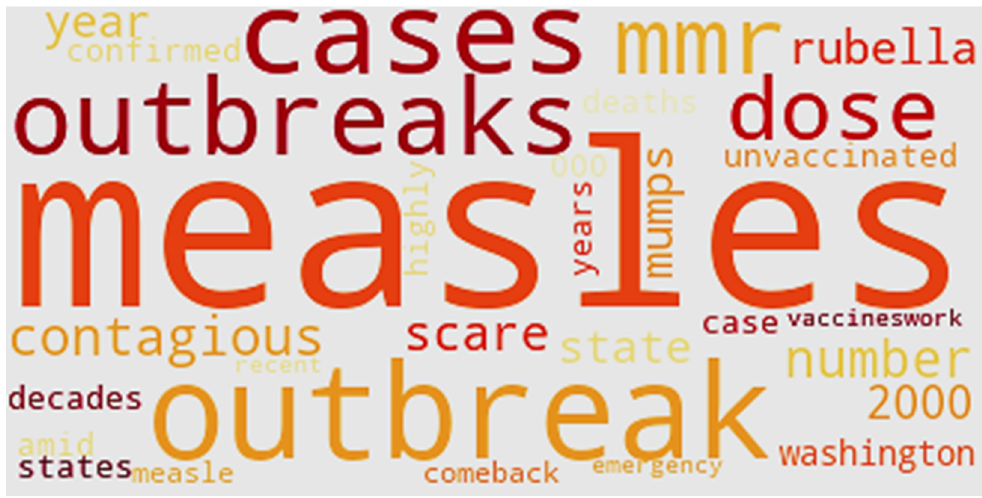
Figure 17. Word cloud of Cluster 2.